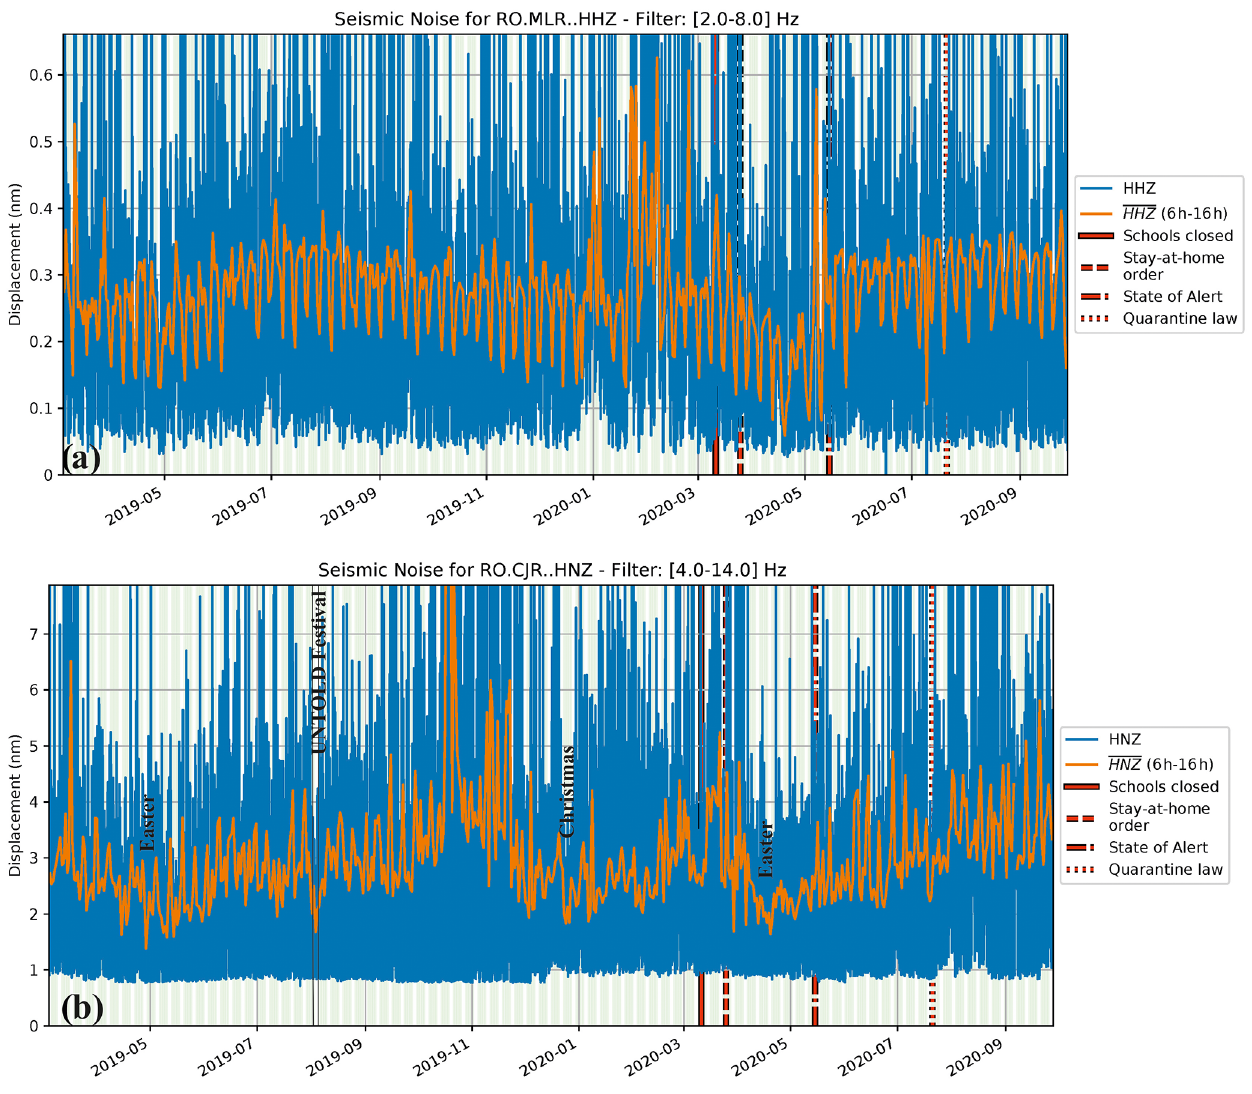
Figure 12. Long-term changes in seismic noise at MLR (a) and CJR (b) stations located in remote places that are less populated. Note the comparable minimum noise level during the UNTOLD Festival and Orthodox Easter and Christmas holidays at CJR station. The locations of the stations are displayed in Fig.